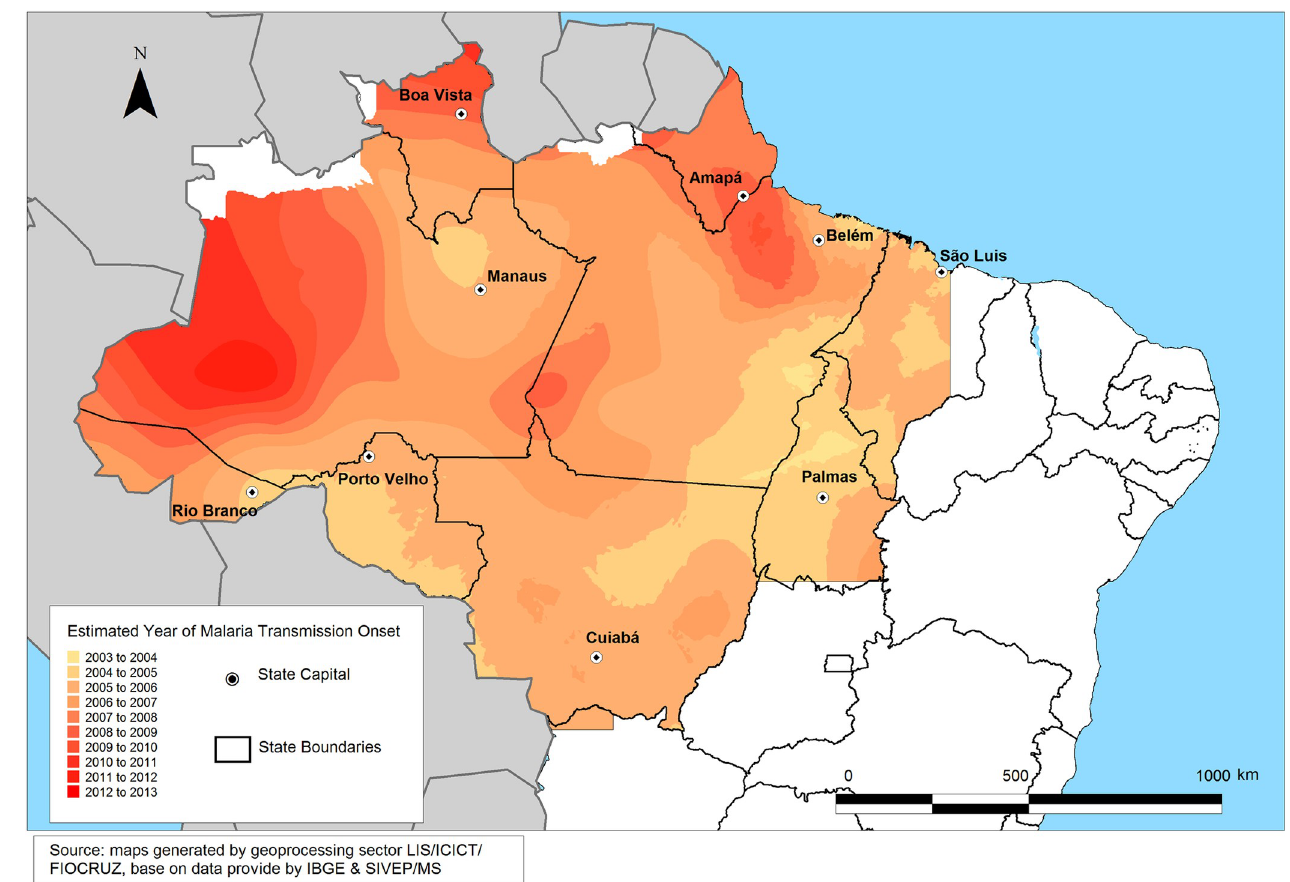
Fig 4. Time trend of sites with high malaria incidence in the Brazilian Amazon